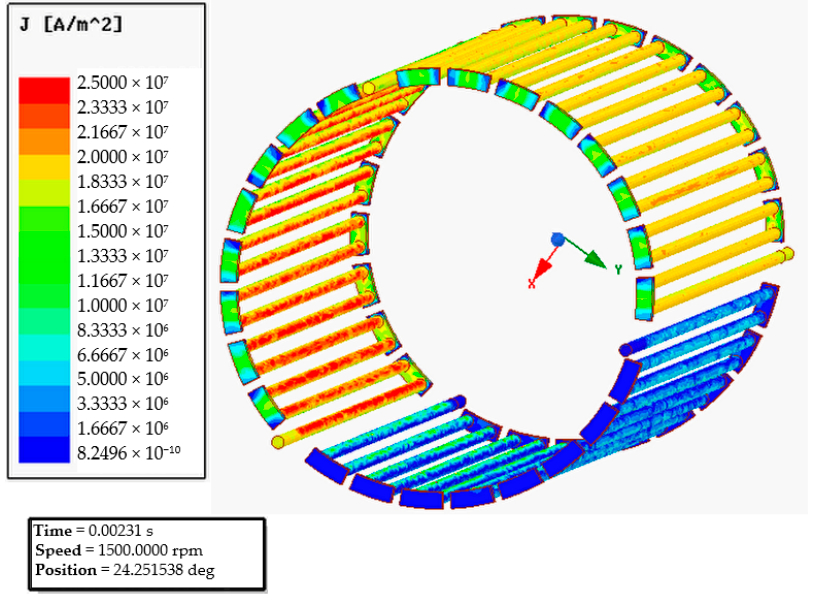
Figure 21. 3D Currents density distribution in the winding.